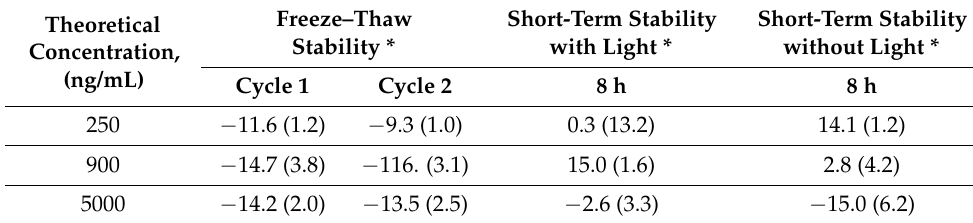
Table 3. Nilotinib stability in human